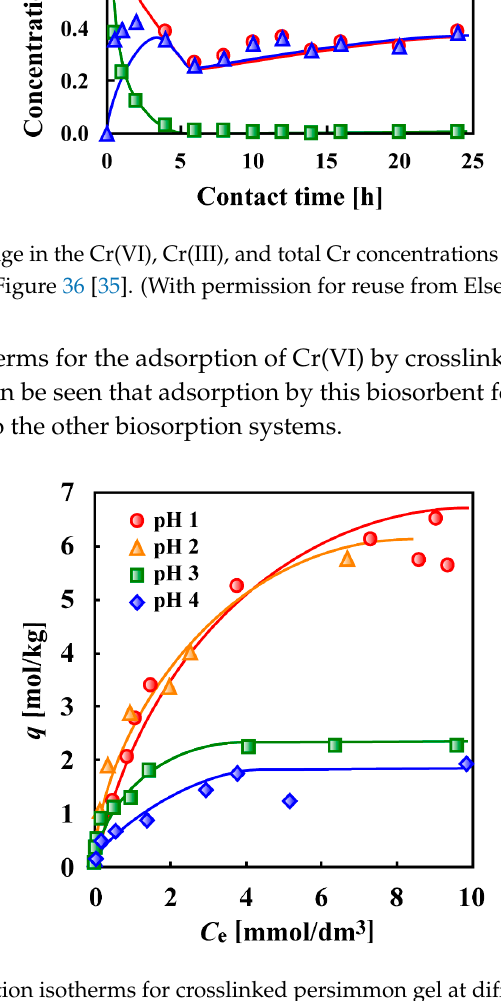
Figure 38. Cr(VI) adsorption isotherms for crosslinked persimmon gel at different pH values at 30 °C . Weight of gel = 10 mg, test solution volume = 10 mL, shaking time = 24 h [35]. (With permission for reuse from Elsevier B.V.).